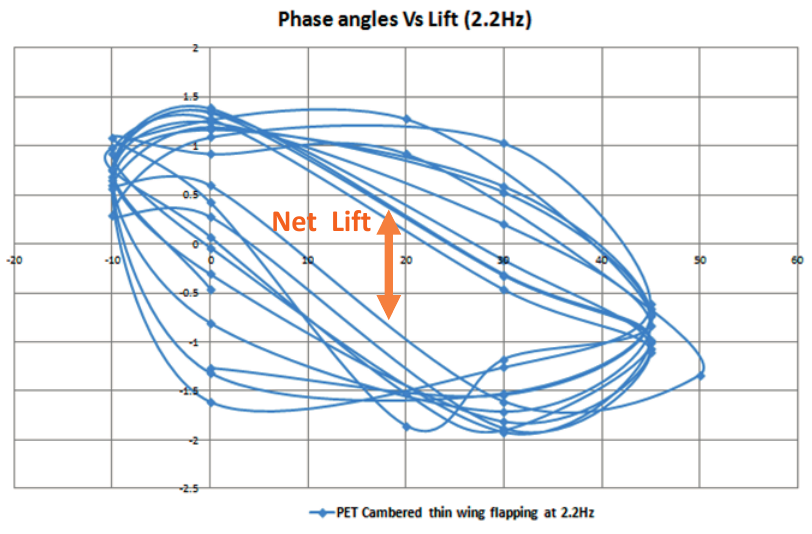
Figure 46. Net lift